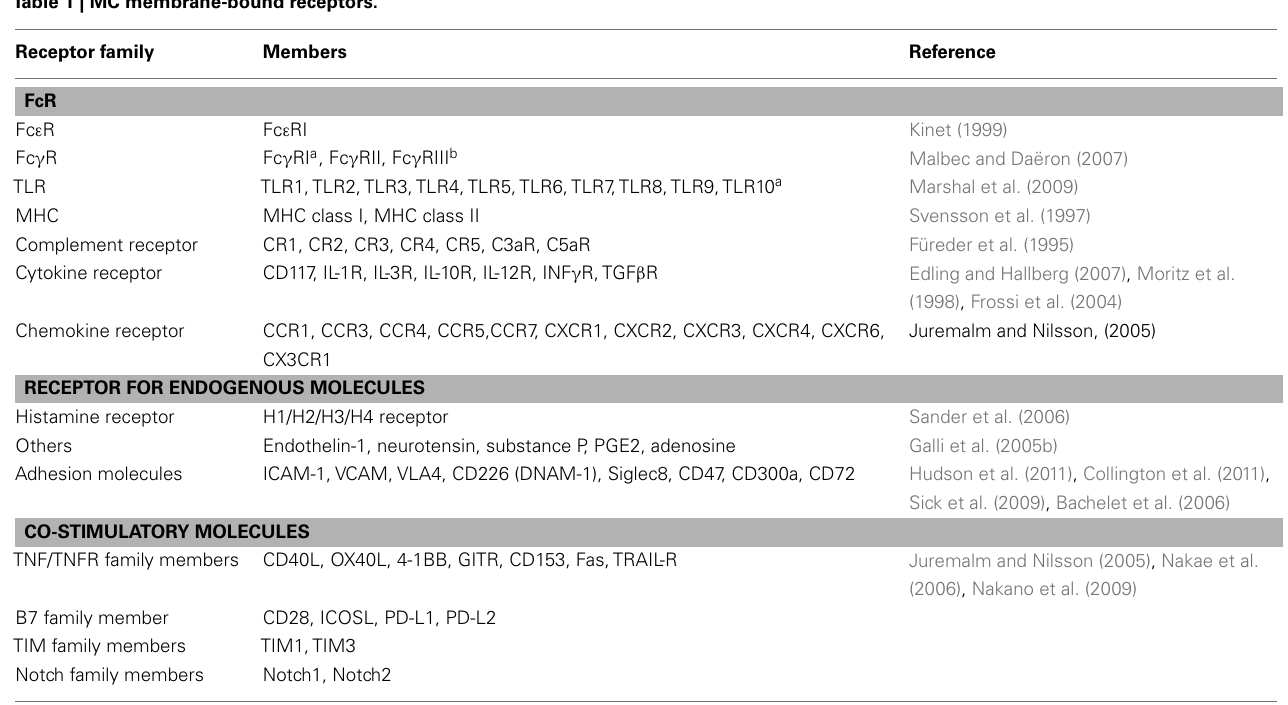
Table 1 | MC membrane-bound